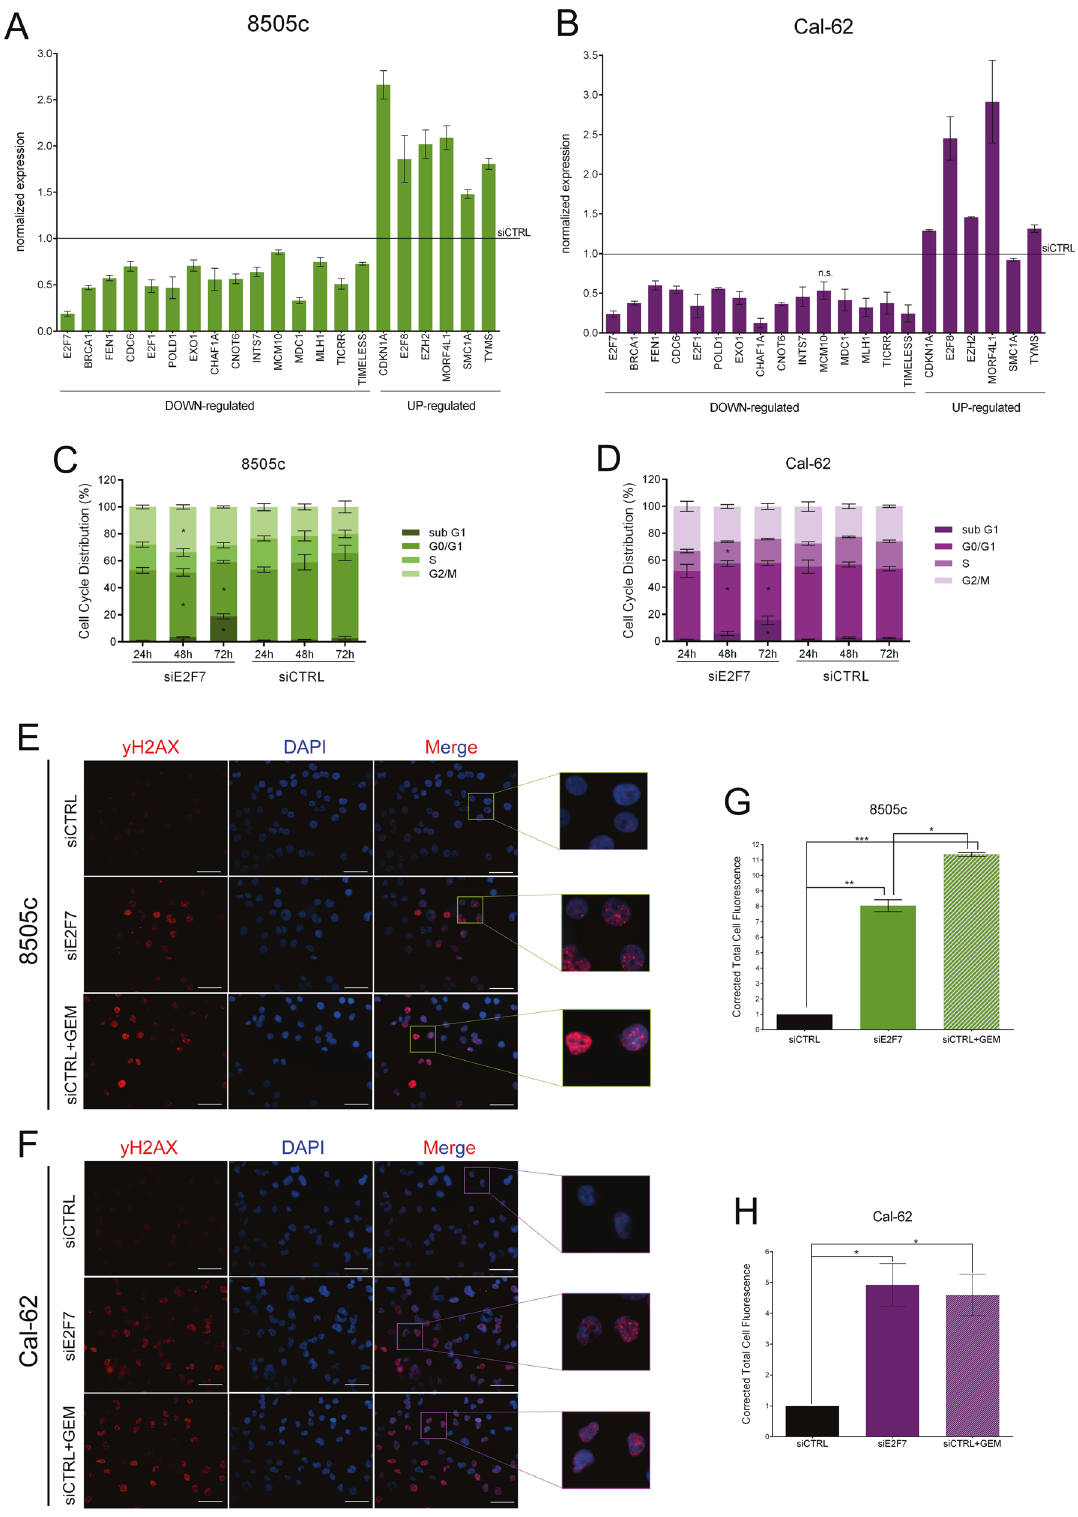
Fig. 5 Validation of E2F7 role on cell cycle and DNA repair. A , B Validation of the 20 top-scoring DEGs from the intersection of RNA-seq and ChIP-seq experiments by qRT-PCR on 8505c and Cal-62 cells 48 h after siRNA transfection, normalized on siCTRL. All the values are statistically signi fi cant (adjusted p -value < 0.05) except where “ n.s. ” is indicated. C , D Cyto fl uorimetric analysis of 8505c and Cal-62 cells after E2F7 silencing for the evaluation of cell cycle phases distribution. E , F Immuno fl uorescence staining of γ H2AX (red) in 8505c and Cal-62 48 h after E2F7 silencing. Gemcitabine was used as positive control for γ H2AX staining. Nuclei are stained with DAPI (blue). Scale bar 50 µm. G , H Corrected Total Cell Fluorescence of 8505c and Cal-62 siE2F7 or siCT + gemcitabine cells stained for γ H2AX, normalized on siCTRL cells, performed with ImageJ. Graphics represent means and SD of two or four independent biological replicates, * p < 0,05, ** p < 0.005.